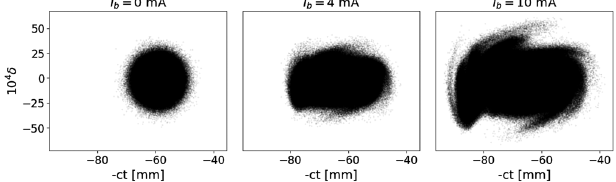
FIG. 4. Simulated longitudinal phase-space plots for three cases. The left shows the zero current, the middle is slightly above the MWT, and the right is well above the